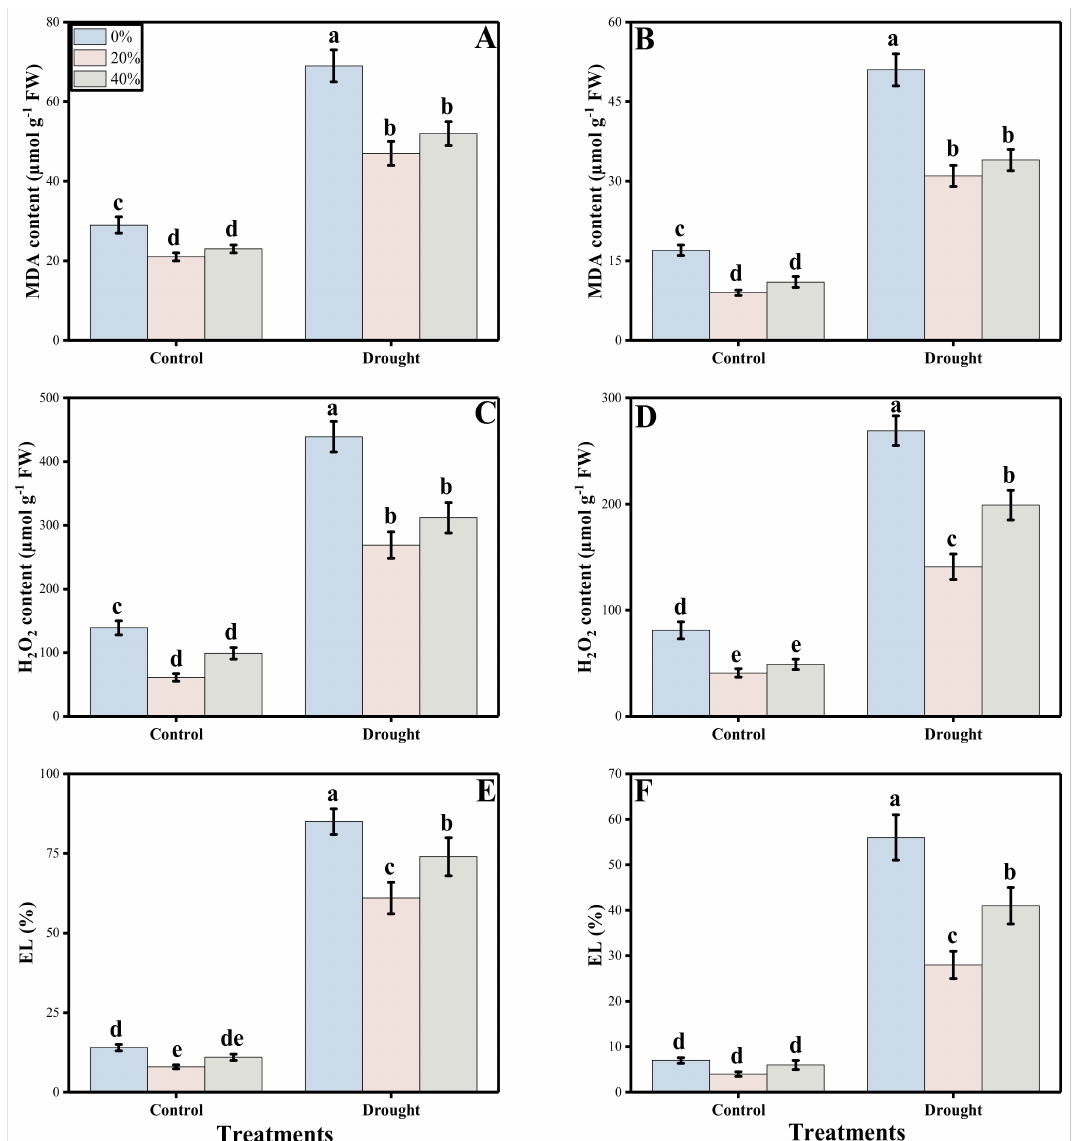
Figure 5. Effect of seed priming with Plantago ovata leaf extract on MDA contents in the roots ( A ), MDA contents in the leaves ( B ), H 2 O 2 contents in the roots ( C ), H 2 O 2 contents in the leaves ( D ), EL percentage in the roots ( E ) and EL percentage in the leaves ( F ) under water stressed and non-stressed environments in maize cultivar Cimmyt-Pak. Means sharing similar letter(s) within a column for each parameter do not differ significantly at p < 0.05. Data in the figures are means of three repeats ( n = 3) of just one harvest of Zea mays plants ± standard deviation (SD). Different lowercase letters on the error bars indicate significant difference between the treatments. Different treatments ( P. ovata extract) used in this study are as follows: 0% (0% P. ovata extract), 20% (20% P. ovata extract) and 40% (40% P. ovata